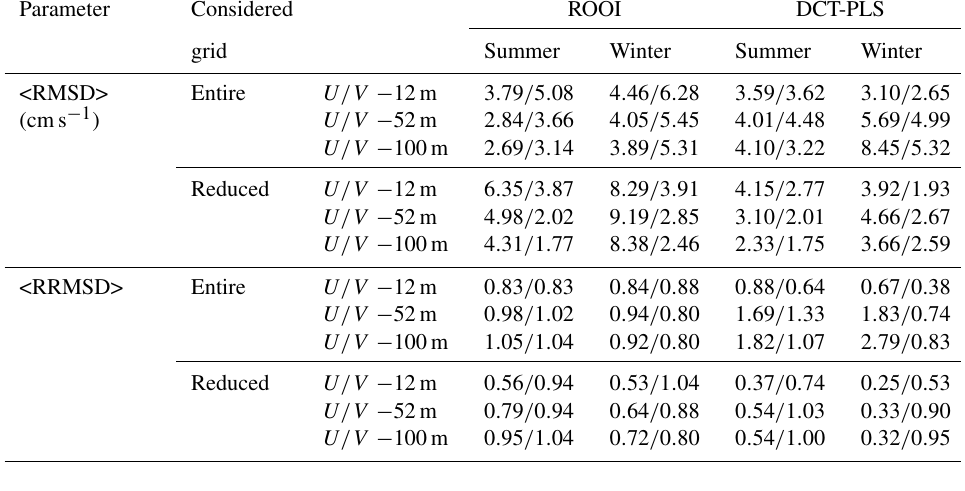
Table 3. Summary of the results of the reconstructions with ROOI (with GLORYS-LR) and DCT-PLS in terms of spatial mean RMSDs and RRMSDs for the entire and reduced grids, the summer and winter study periods, and different depths.